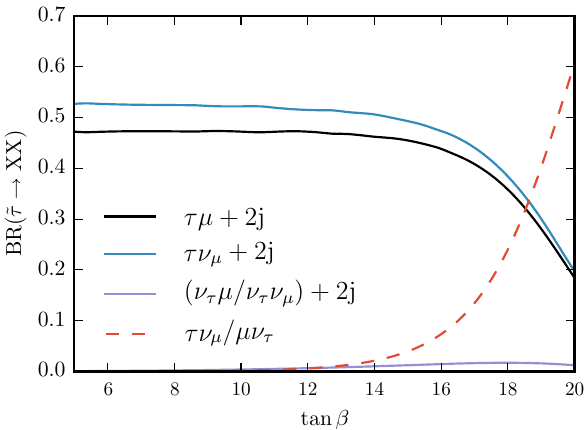
Fig. 6 Superfield Feynman diagrams corresponding to the one-loop RGE-induced λ i 33 operators. The diagrams assuming non-zero λ (cid:4) are shown on the left- and right-hand side, respectively